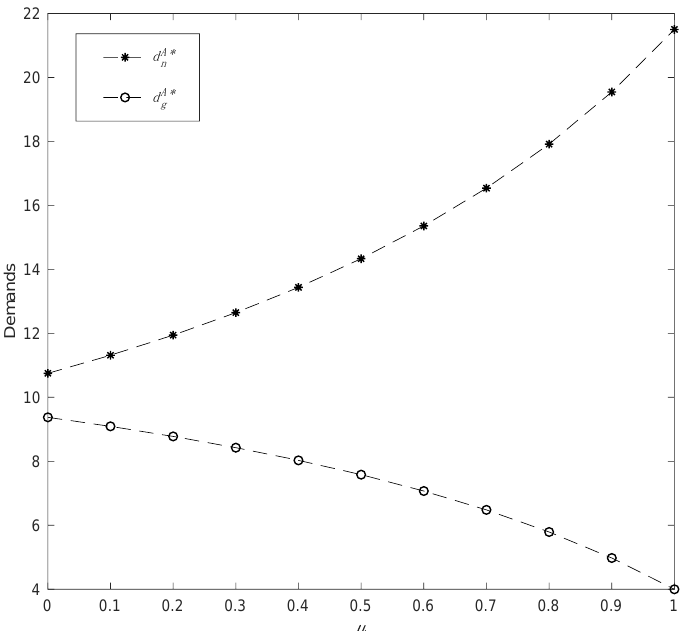
Figure 7. The change in demands with parameter μ.